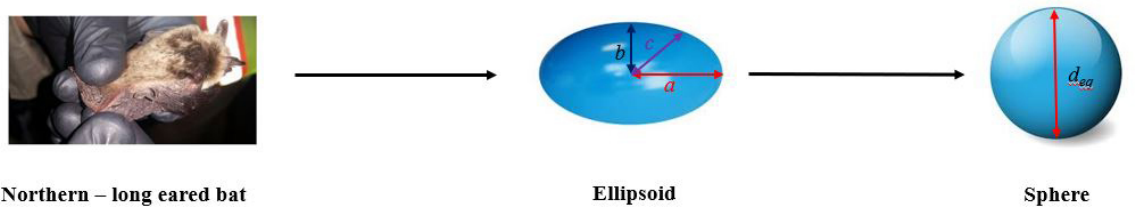
Figure 3. Illustration of the simplified geometric representation of bats for the ballistics model. The image (WEST, Inc., 2016) is of a northern long-eared myotis.